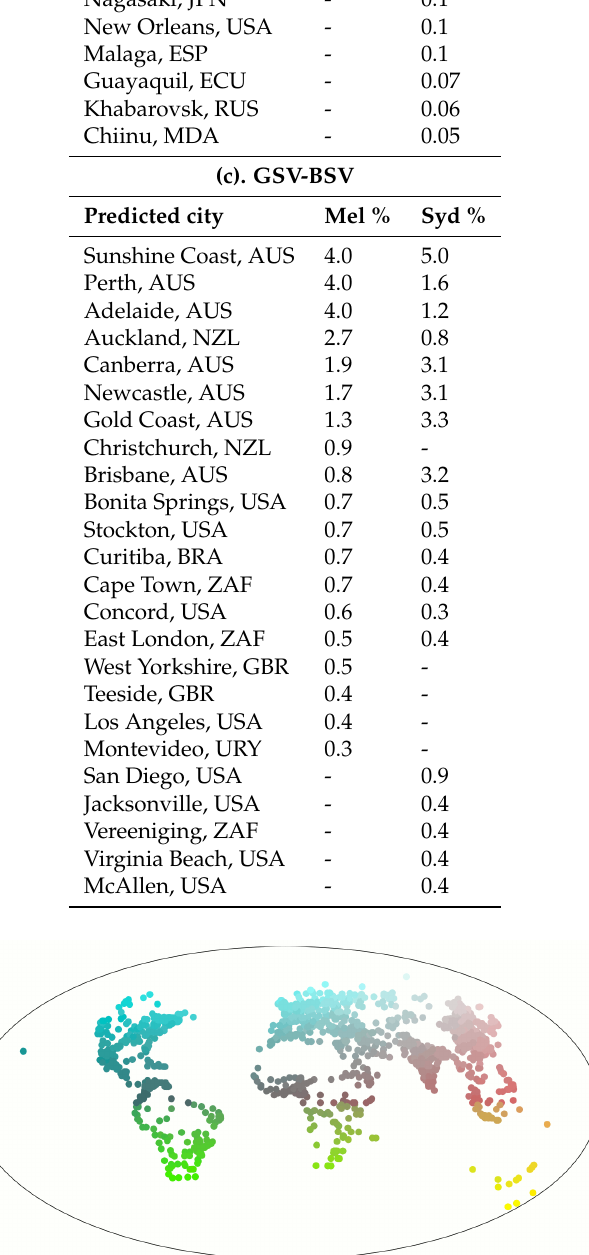
Figure 2. Latitude–longitude-based colour scheme for plotting neural network predictions of cities similar to Melbourne and